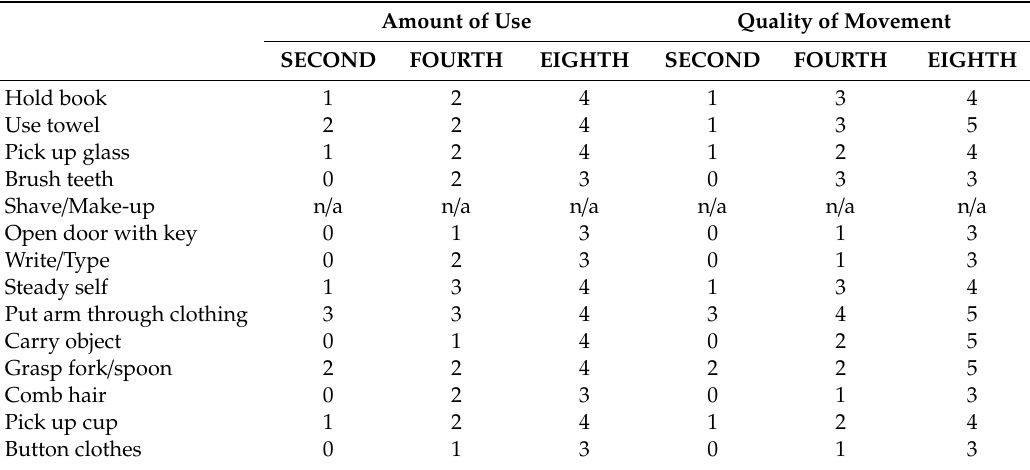
Table A1. Each item of amount of use (AOU) and quality of movement (QOM) for Patient